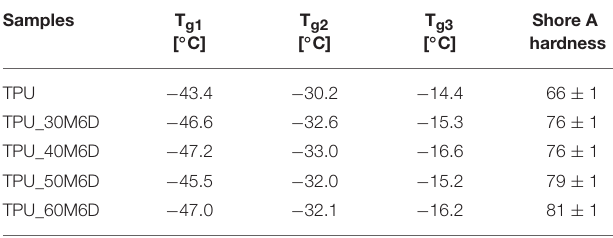
TABLE 4 | Glass transition temperatures (T g ) values from DMTA tests on neat TPU and relative blends.